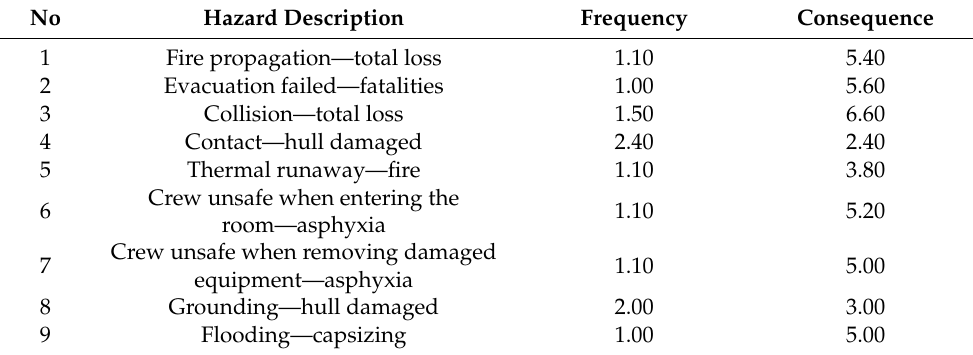
Table 8. HAZID questionnaire results—emergency